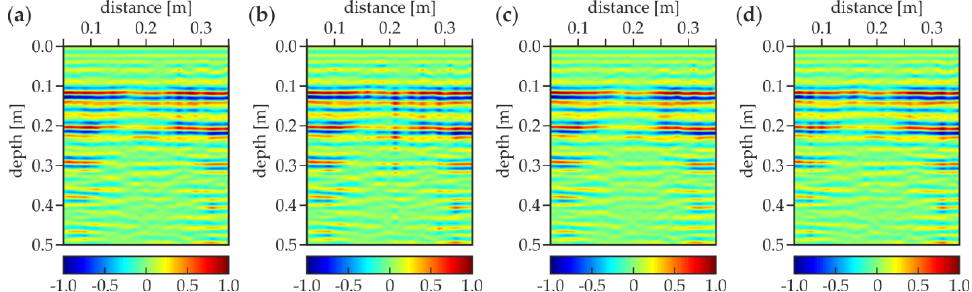
Figure 13. Ultrasonic B ‐ scans for concrete slabs with air gap of thicknesses ( a ) 1 mm (trace D ‐ 1); ( b ) 4 mm (trace D ‐ 2); ( c ) 20 mm (trace D ‐ 3); and ( d ) 50 mm (trace D ‐